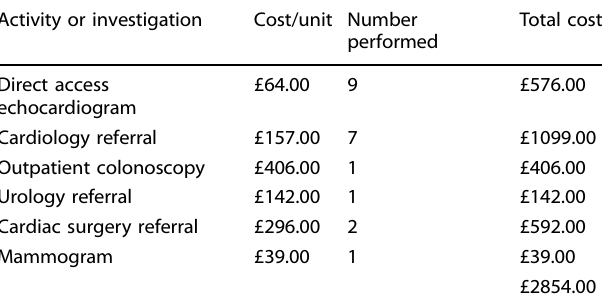
Table 2. Costs of subsequent imaging studies and secondary care referrals following LHC